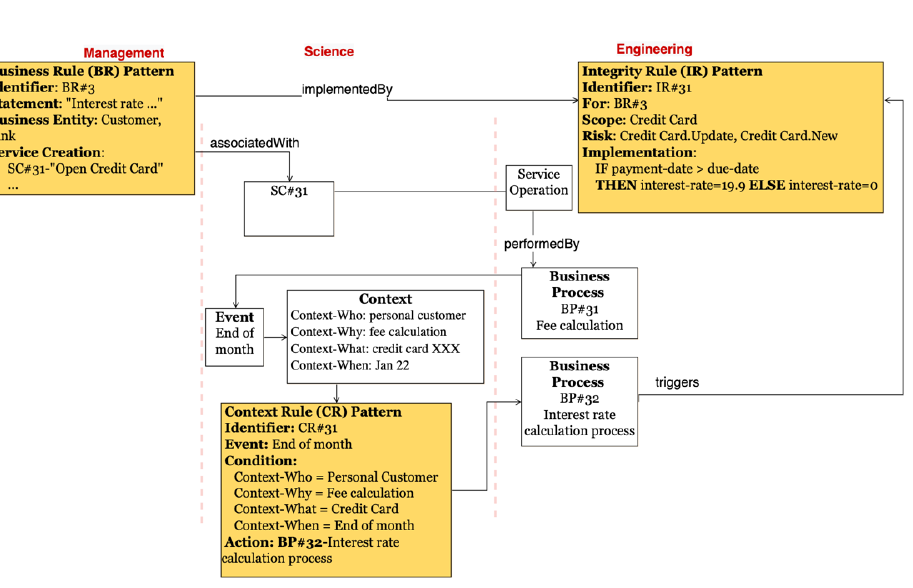
Fig. 6. Example of RuCBS patterns for describing